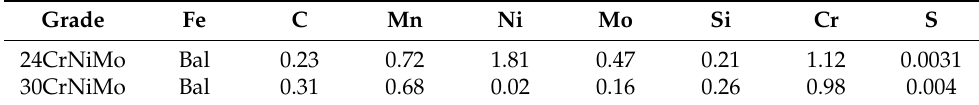
Table 3. Chemical composition of 24CrNiMo powder and 30CrNiMo plate (%).